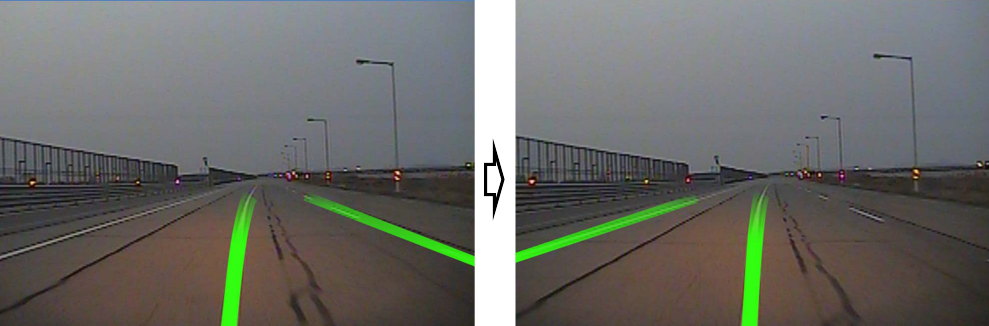
Figure 1. Example of jumped lane information during the lane change toward